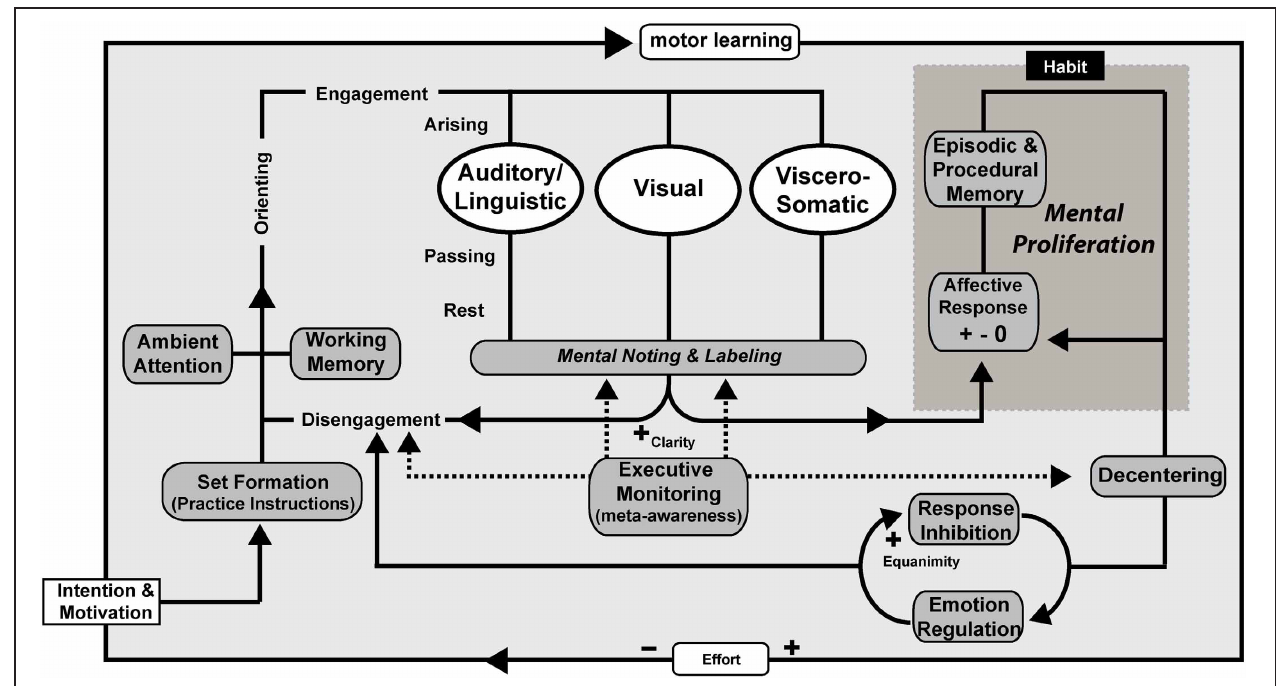
FIGURE 4 | Mindfulness process model—open monitoring receptive practice. OM meditation with no object of focus (ambient attention) is illustrated as an example, but the processes are proposed to be the same across receptive styles of practice. Intention is formed along with motivation to practice before an executive “set” is created. The working memory system helps to maintain motivation and practice instructions. Ambient (diffuse) attentional networks are recruited and sustained along with support by component mechanisms including executive monitoring, emotion regulation, and response inhibition. Mental noting and labeling of stimuli arising, passing,